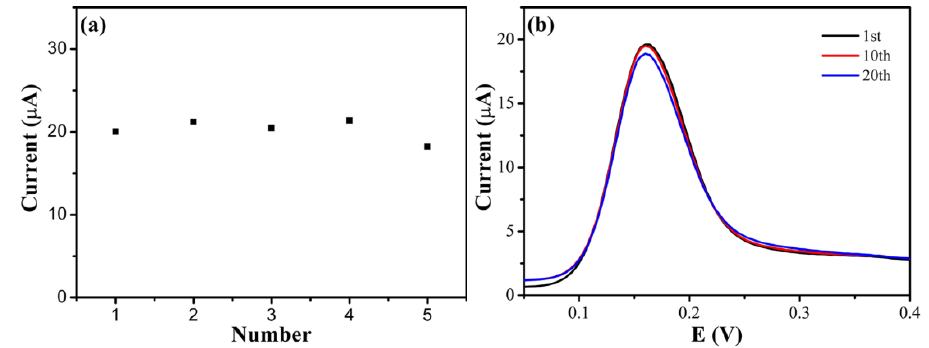
Figure 10. DPVs of Bi 2 S 3 /rGO-3/GCE in 0.1 M PBS containing 1 mM AA ( a ) for five independently